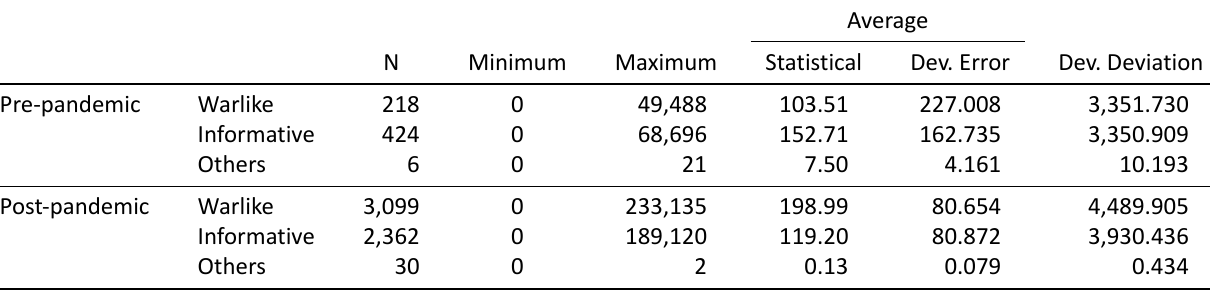
Table 1. Descriptive statistics on